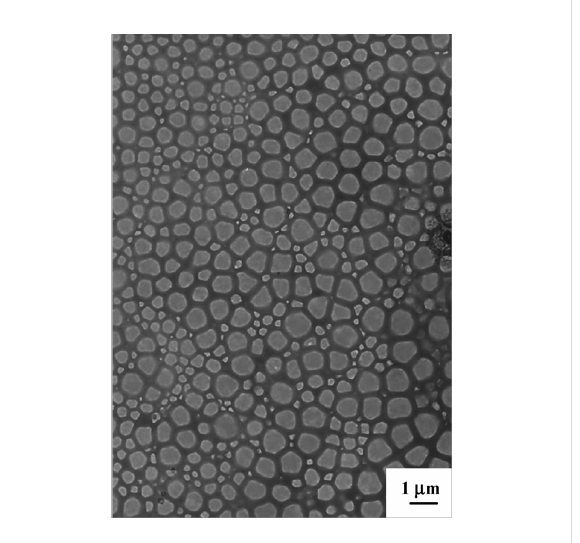
Figure 7: Transmission electron micrograph of polyurethane capsules synthesized by interfacial polyaddition in inverse miniemulsion (reprinted with permission from [116]. Copyright (2007) American Chemical